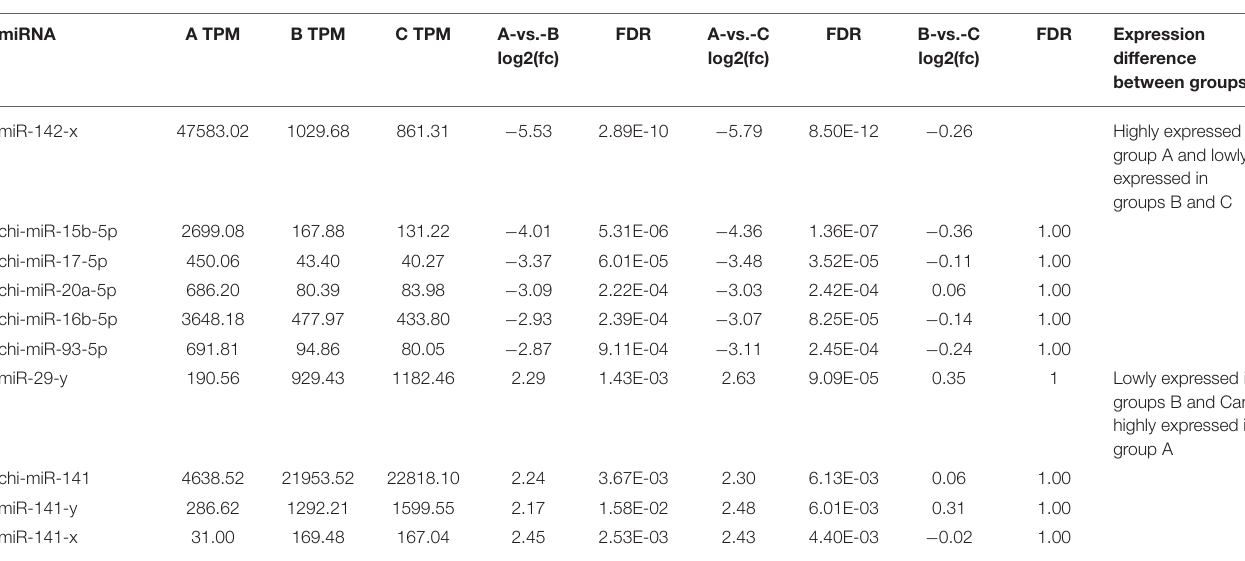
TABLE 5 | Expression of core miRNAs in different